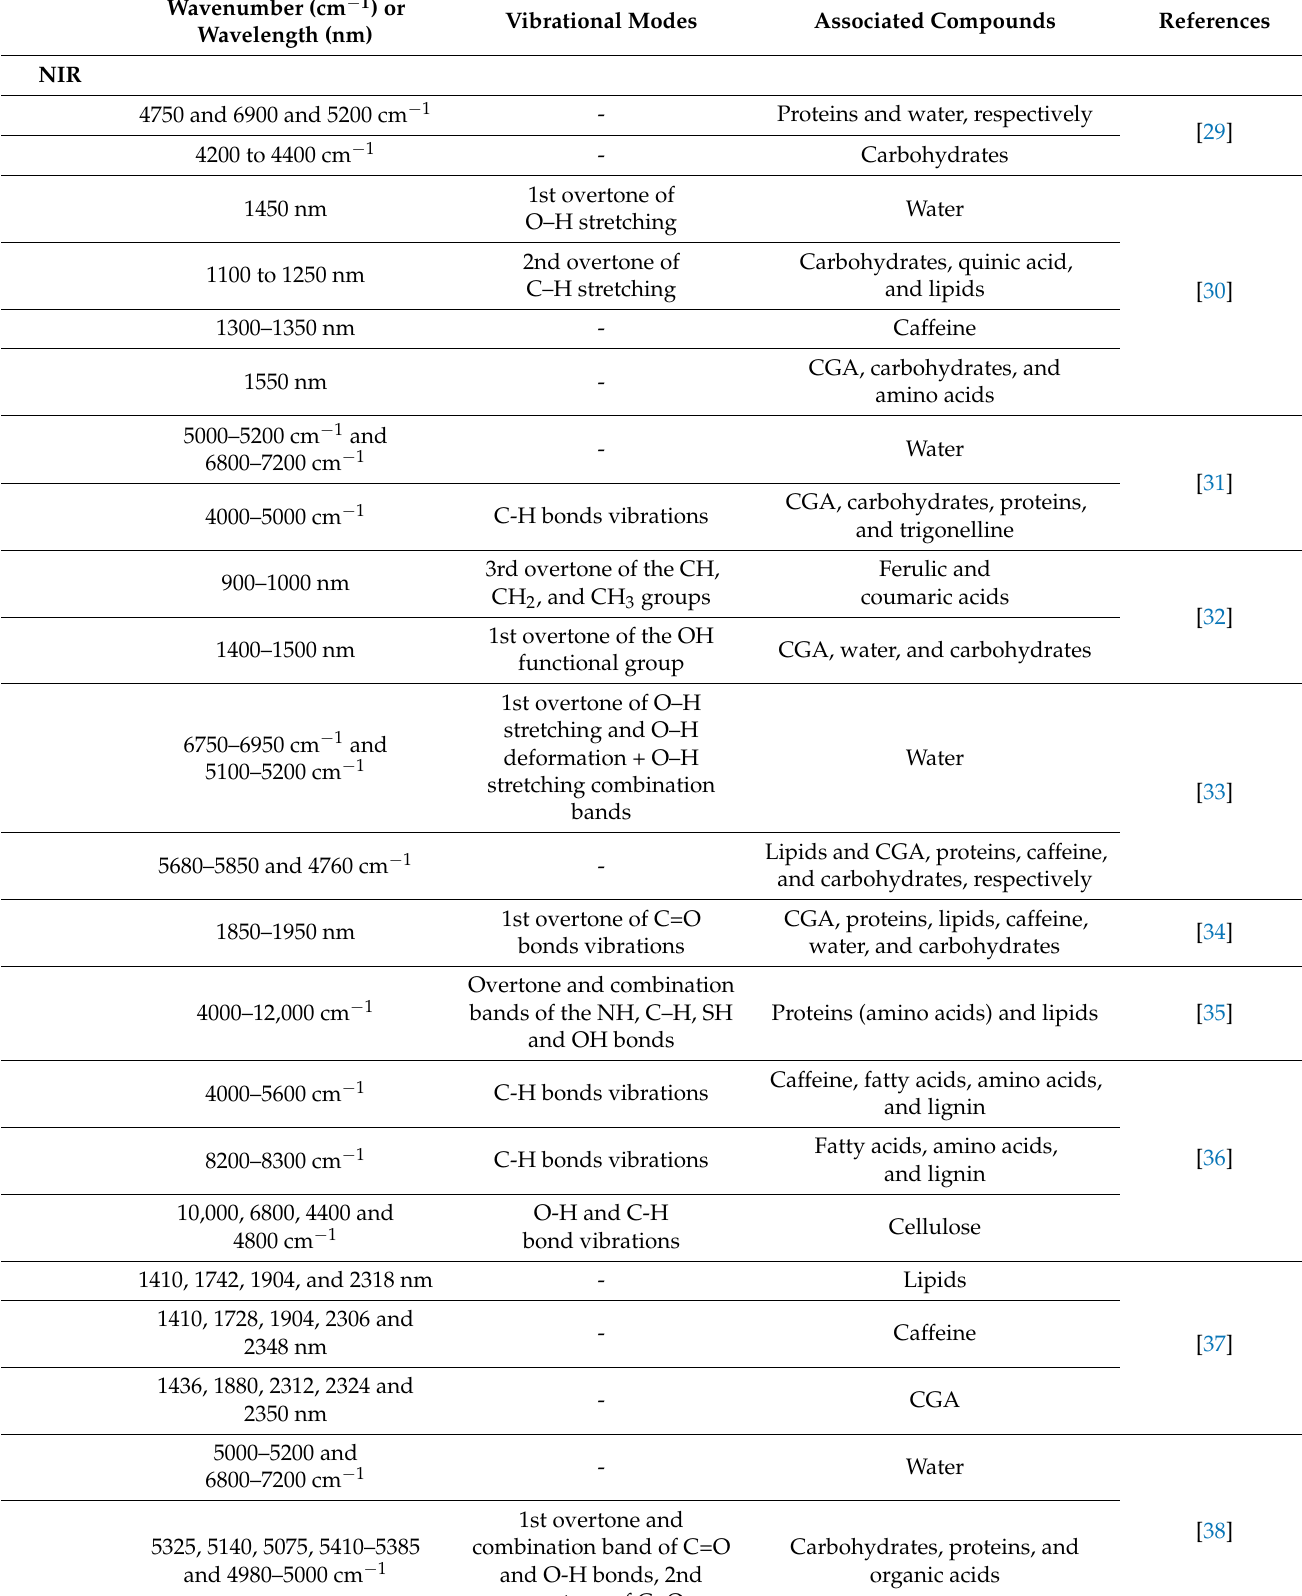
Table 1. Reported absorption bands of coffees chemical components in the IR and Raman